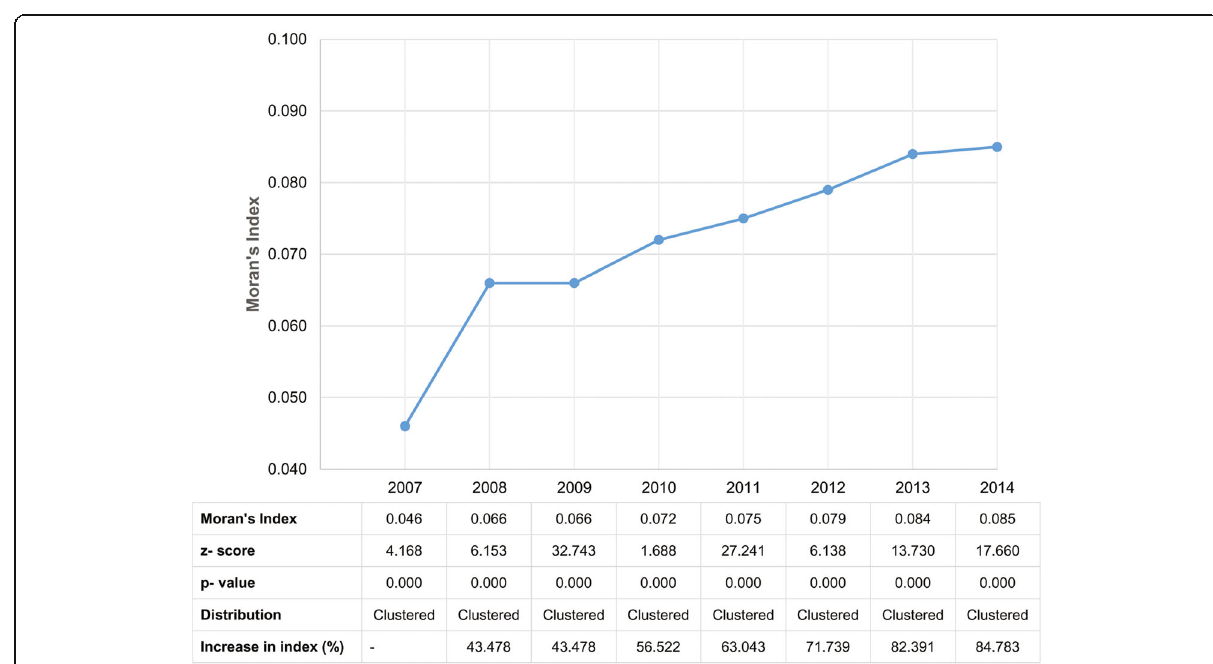
Fig. 2 Inter-year comparison of Global Moran ’ s I autocorrelation test (with 2007 as the base